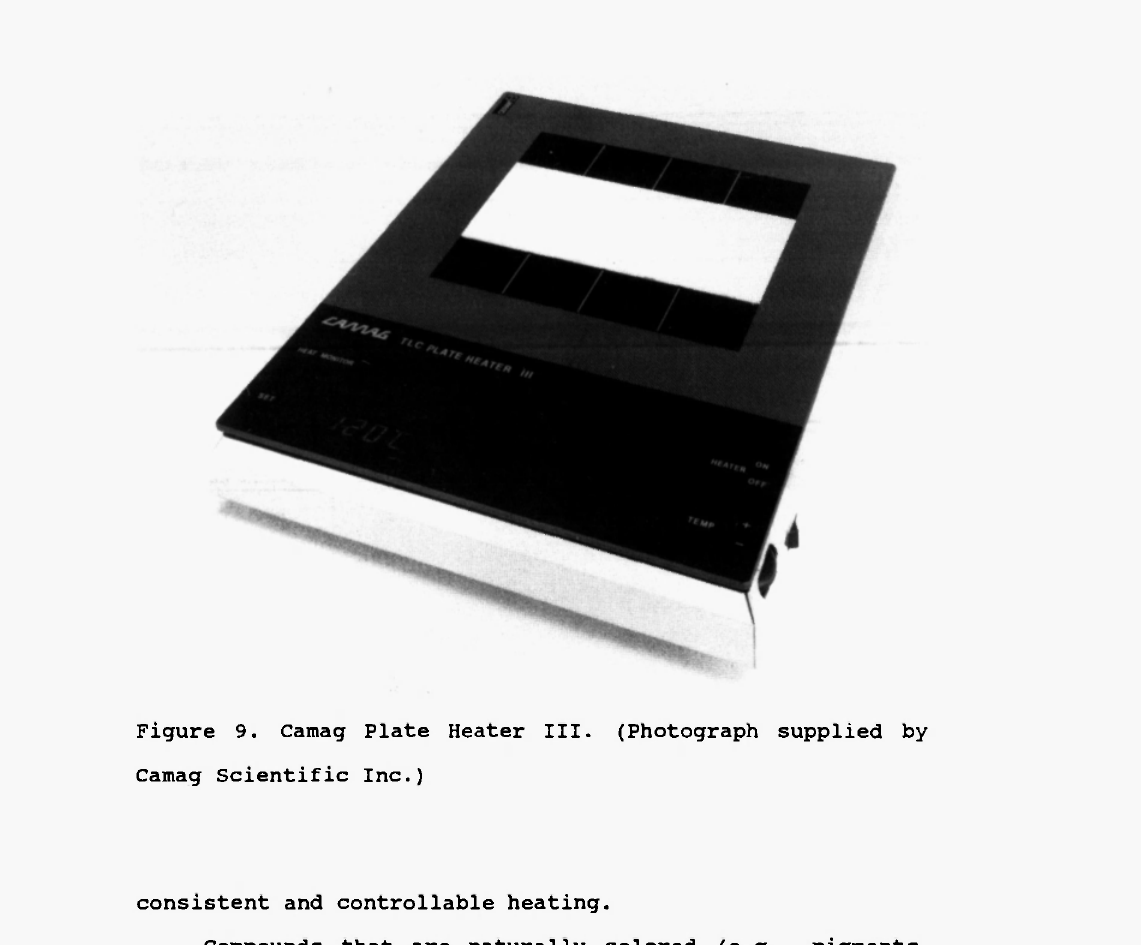
Figure 9. Camag Plate Heater III. (Photograph supplied by Camag Scientific